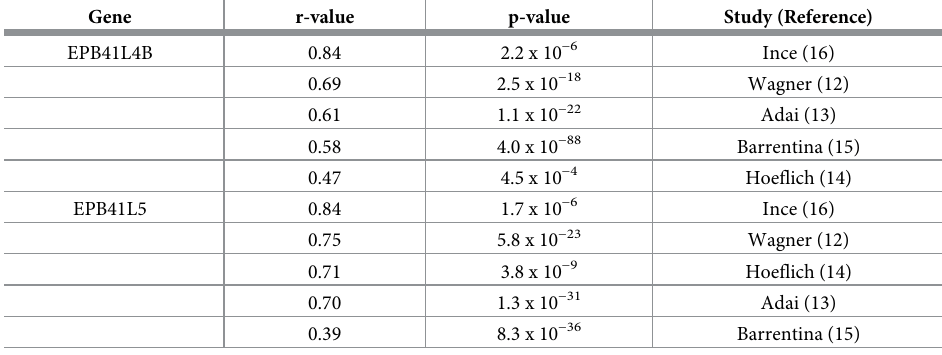
Table of the Pearson coefficients (r-values) and p-values from correlation analysis of CRB3 and EPB41L4B or EPB41L5 mRNA in the listed studies. The r-value is a measure of the linear association between two variables between -1 and 1; positive r-values indicate a positive linear relationship. The threshold for statistically significant correlation was p =